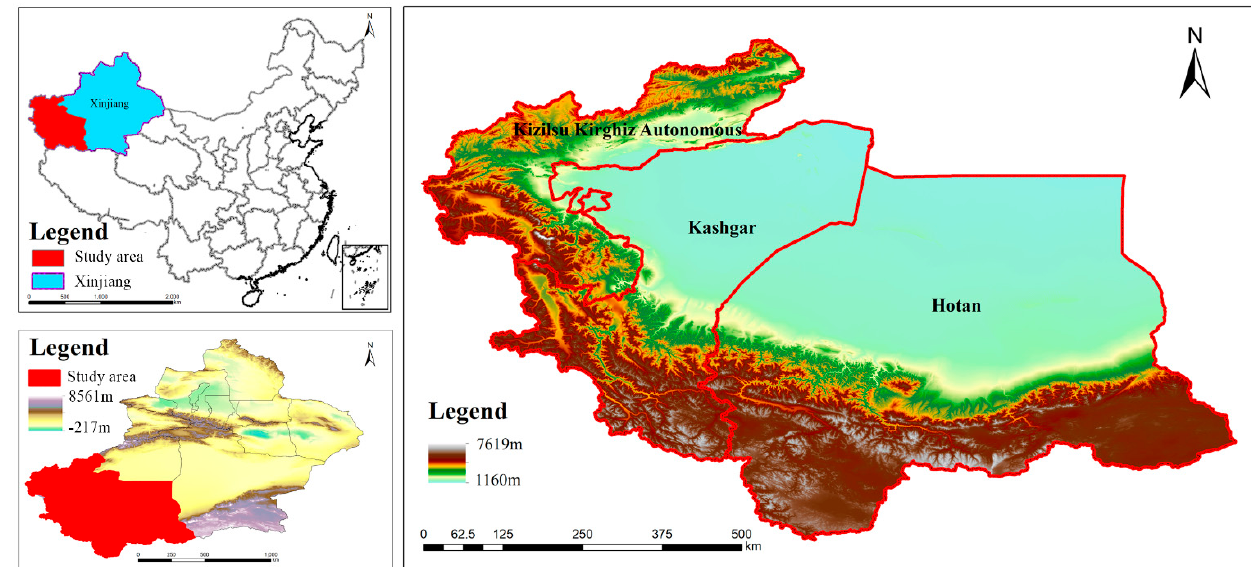
Figure 1. Study area.